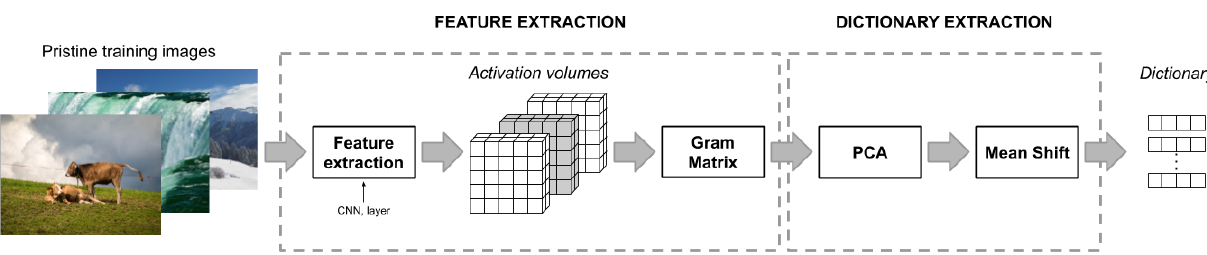
Figure 4. Overview of the creation of the dictionary for the degree of abnormality computation. The activation volumes of a given CNN are extracted and then the Gram matrix is computed to get the intra-layer correlation for a subset of pristine images. Subsequently dimensionality reduction is applied through Principal Component Analysis (PCA). Finally Mean Shift algorithm is performed to compute clusters on which centroids are then extracted as entry of the